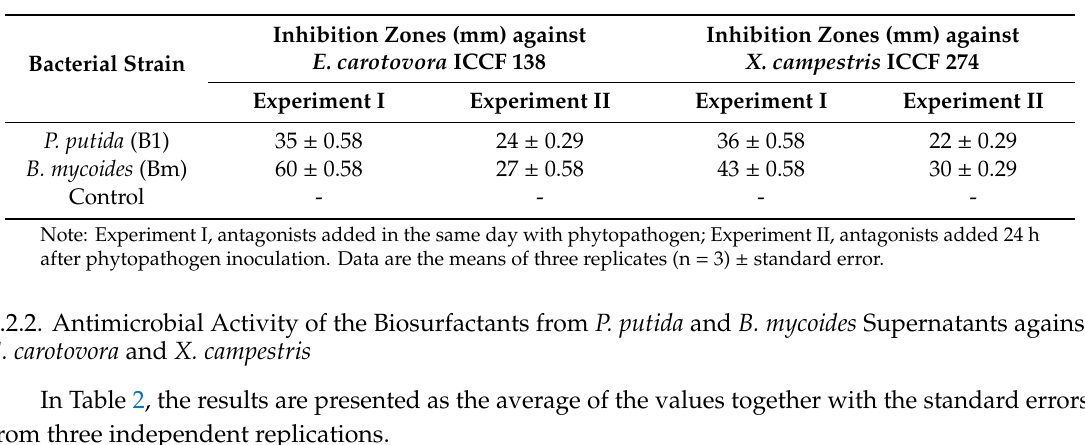
Table 1. Antimicrobial activity of antagonists after 48 h of growth together with phytopathogens E. carotovora ICCF 138 and X. campestris ICCF 274.